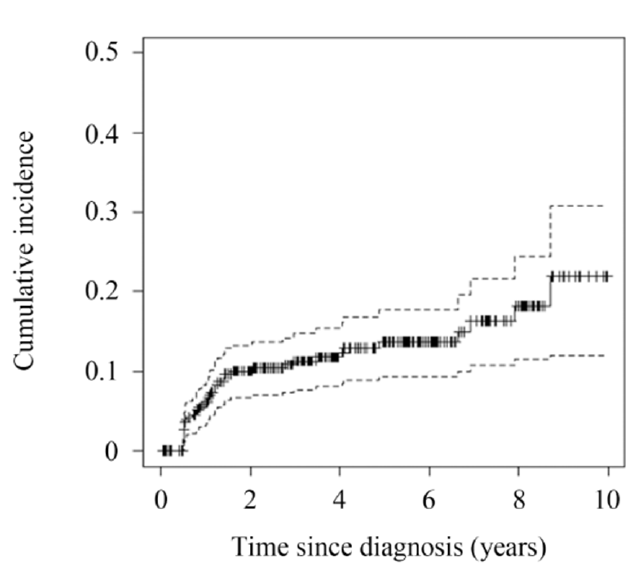
Figure 2. Cumulative incidence of second primary cancers in uveal melanoma patients.